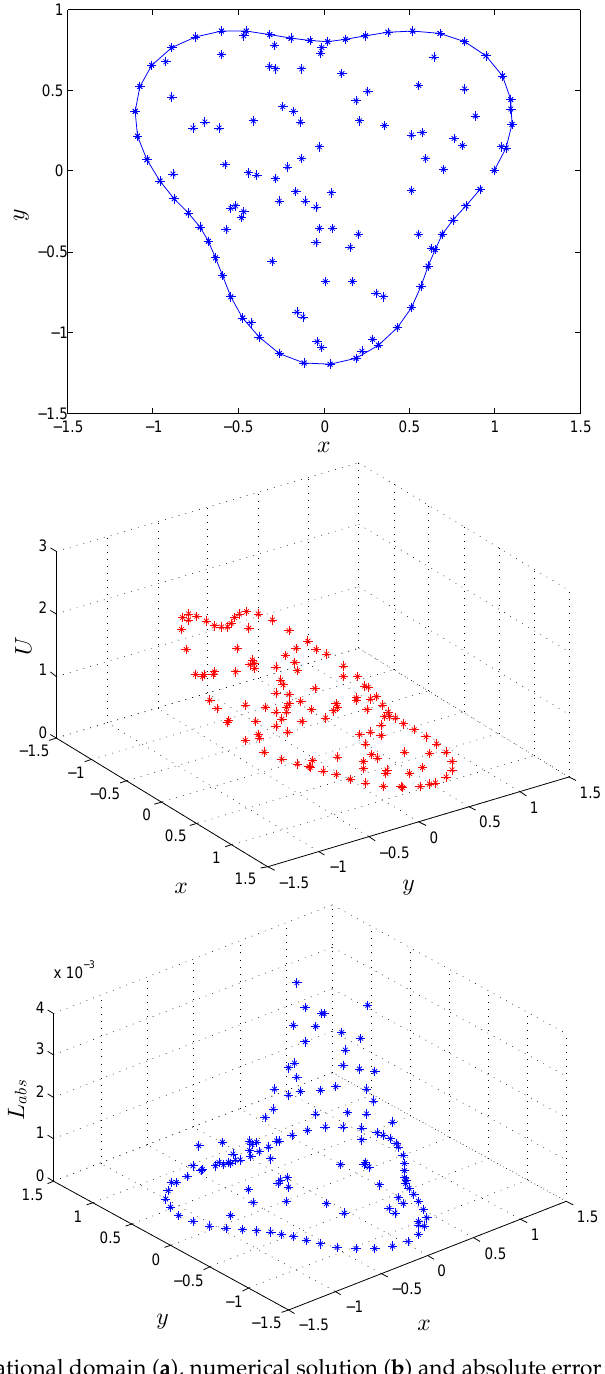
Figure 4. Computational domain ( a ), numerical solution ( b ) and absolute error ( c ) by using the EEM for Test Problem